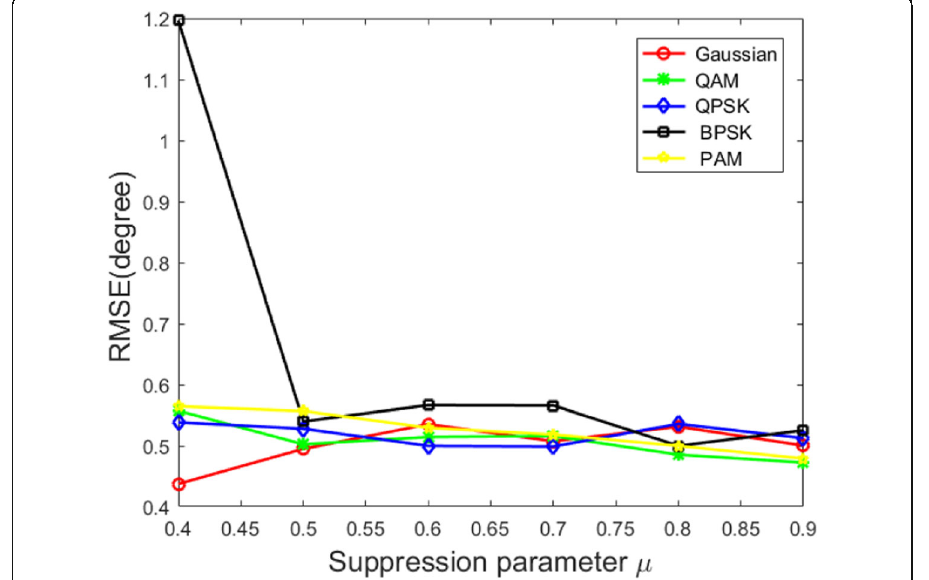
Fig. 7 RMSE against suppression parameter